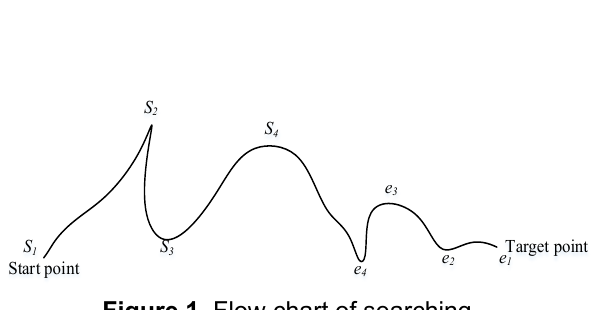
Figure 1. Flow chart of